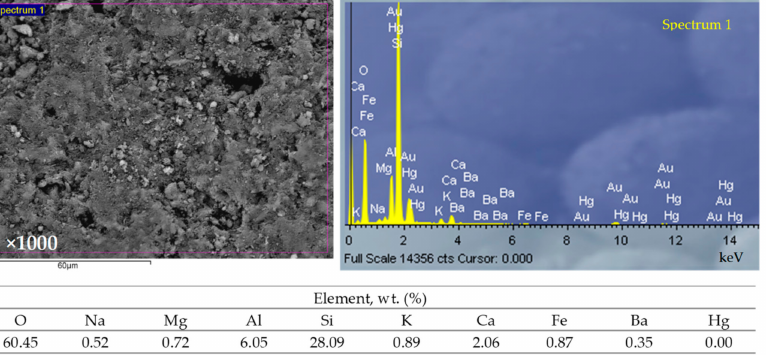
Figure 15. SEM image and EDS results for NZ of particle size 0.6–0.8 mm after sorption of total mercury leached for pH o of ultrapure water of